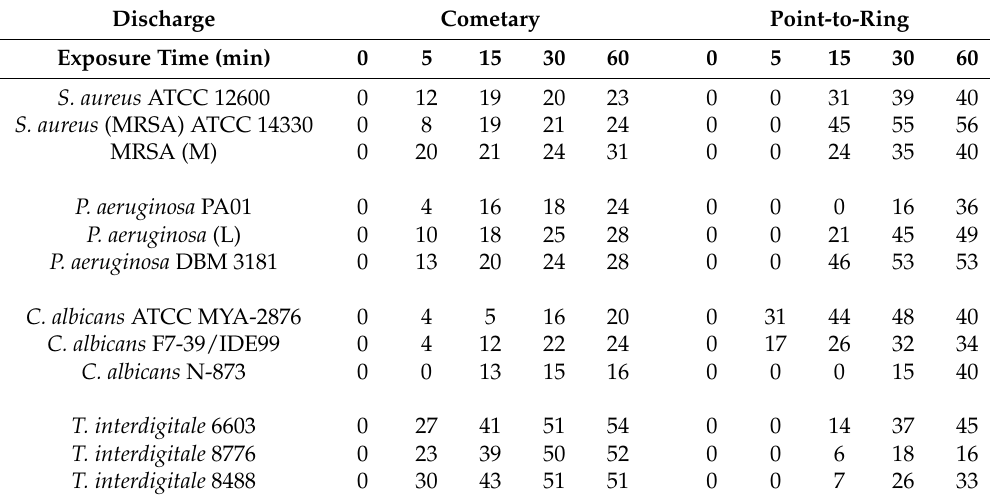
Table 1. Areas of incomplete inhibition (in cm 2 ) after exposure of individual microorganisms to the cometary/point-to-ring discharge.